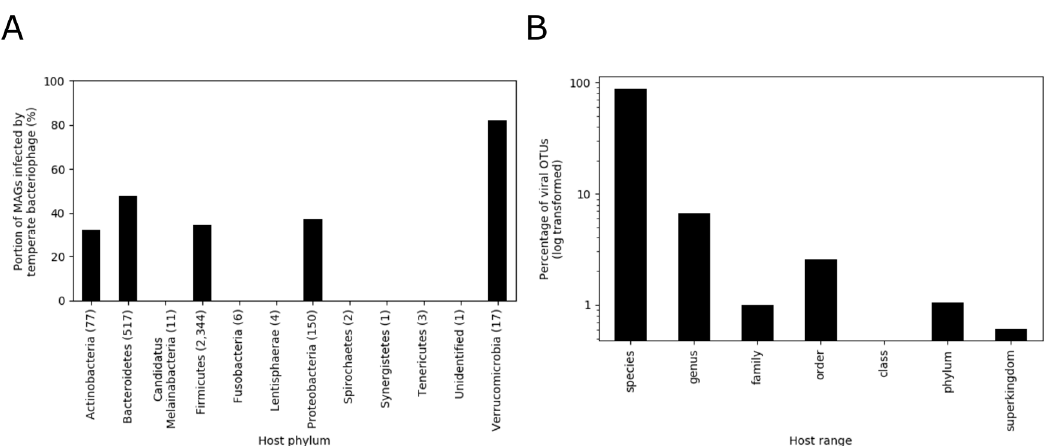
Figure 2. Phylogenetic tree based on a comprehensive collection of reconstructed bacterial genomes. The inner layer colors correspond to the bacterial phyla represented at the tip of each branch. The outer layer indicates bacteria associated with functional temperate bacteriophages.